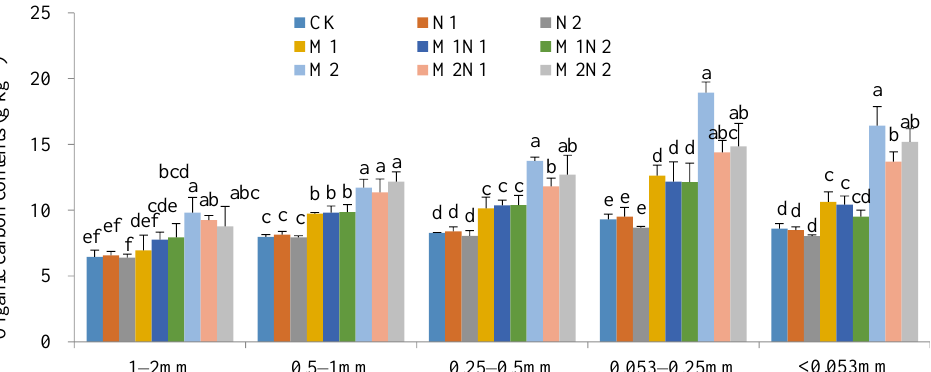
Figure 4. Contents of organic carbon in soil aggregates after 38–year fertilization with nine treatments. CK: no fertilizer, N1: low nitrogen, N2: high nitrogen, M1: low manure, M1N1: low manure and low nitrogen, M1N2: low manure and high nitrogen, M2: high manure, M2N1: high manure and low nitrogen, M2N2: high manure and high nitrogen. Different lower–case letters denote significant differences between treatments by least – significant difference at the 5% level.